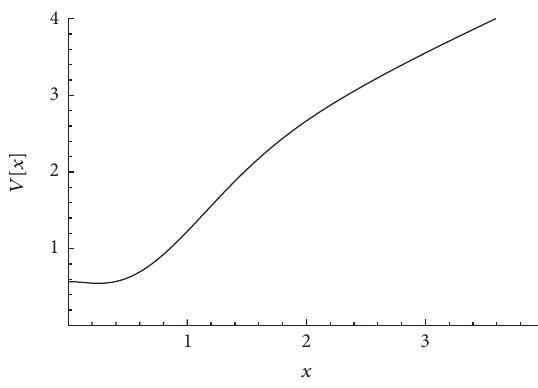
Figure 1: The potential 𝑉 , as a function of 𝑥 = 𝑟/2√𝜃